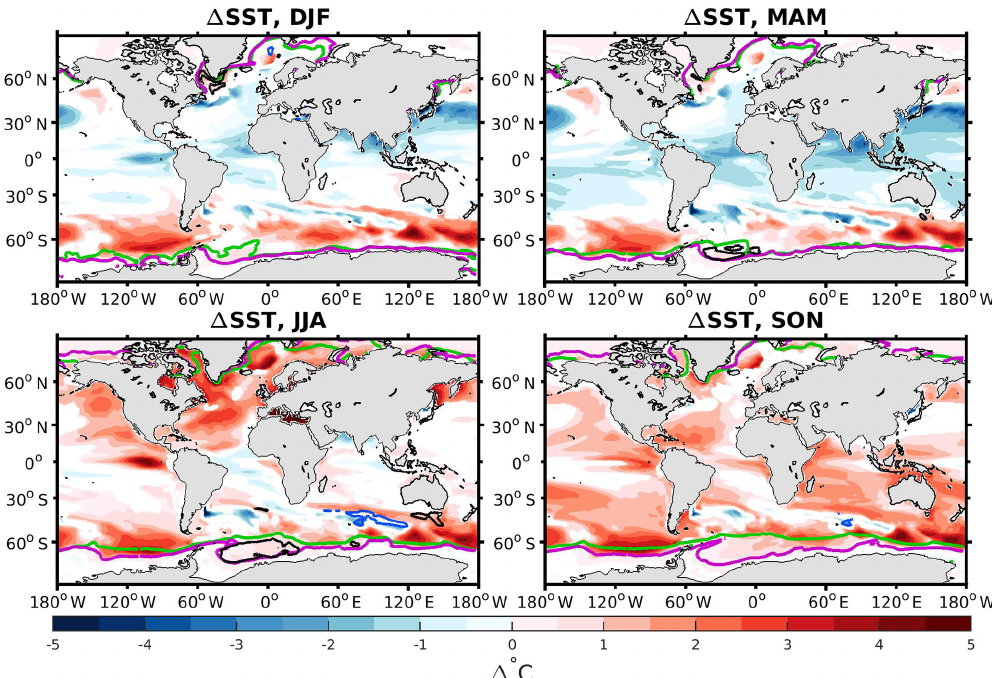
Figure 1. Difference in sea surface temperature ( (cid:49) SST) between 125 and 115ka. Only significant differences (i.e., with absolute value greater than the interannual standard deviation over the last 50 years in both 125 and 115ka) are shown. The green and purple lines correspond to 50% sea ice extent at 115 and 125ka, respectively. The black (blue) thick lines depict regions affected by a deepening (shallowing) of the mixed-layer depth (with difference greater than 100m depth) at 125ka compared to 115ka.